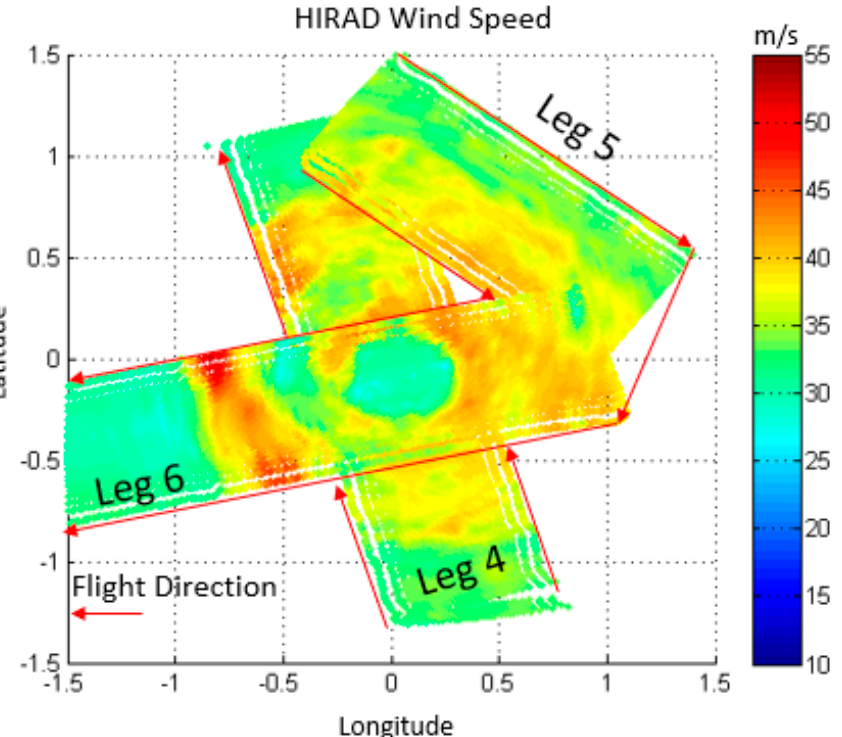
Figure 13. HIRAD Figure-4 over Gonzalo, where Leg 4, 5, and 6 wind speeds are plotted in storm- relative coordinates with the color axis in